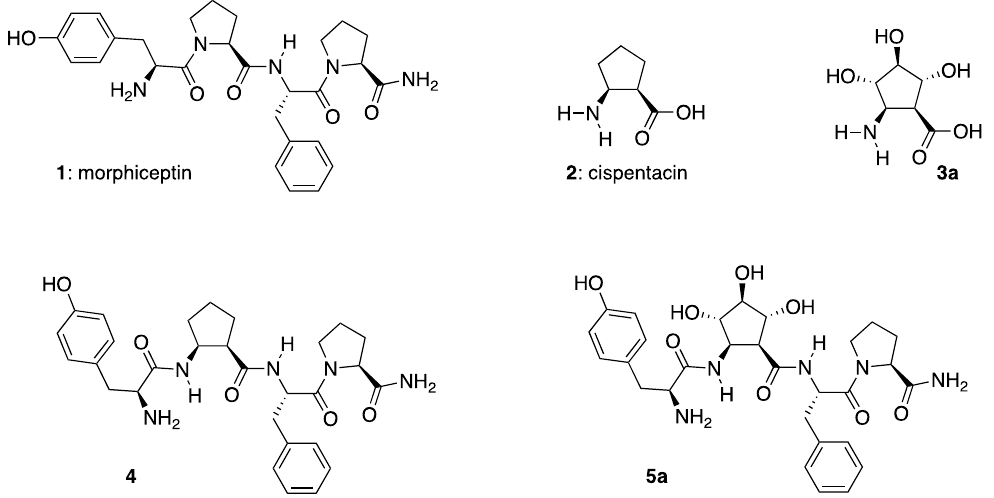
Figure 1. Cispentacin, ( 1S,2R,3S,4S,5R )-3,4,5-trihydroxycispentacin ( 3a ) and their respective morphiceptin peptidomimetics 4 and 5a .